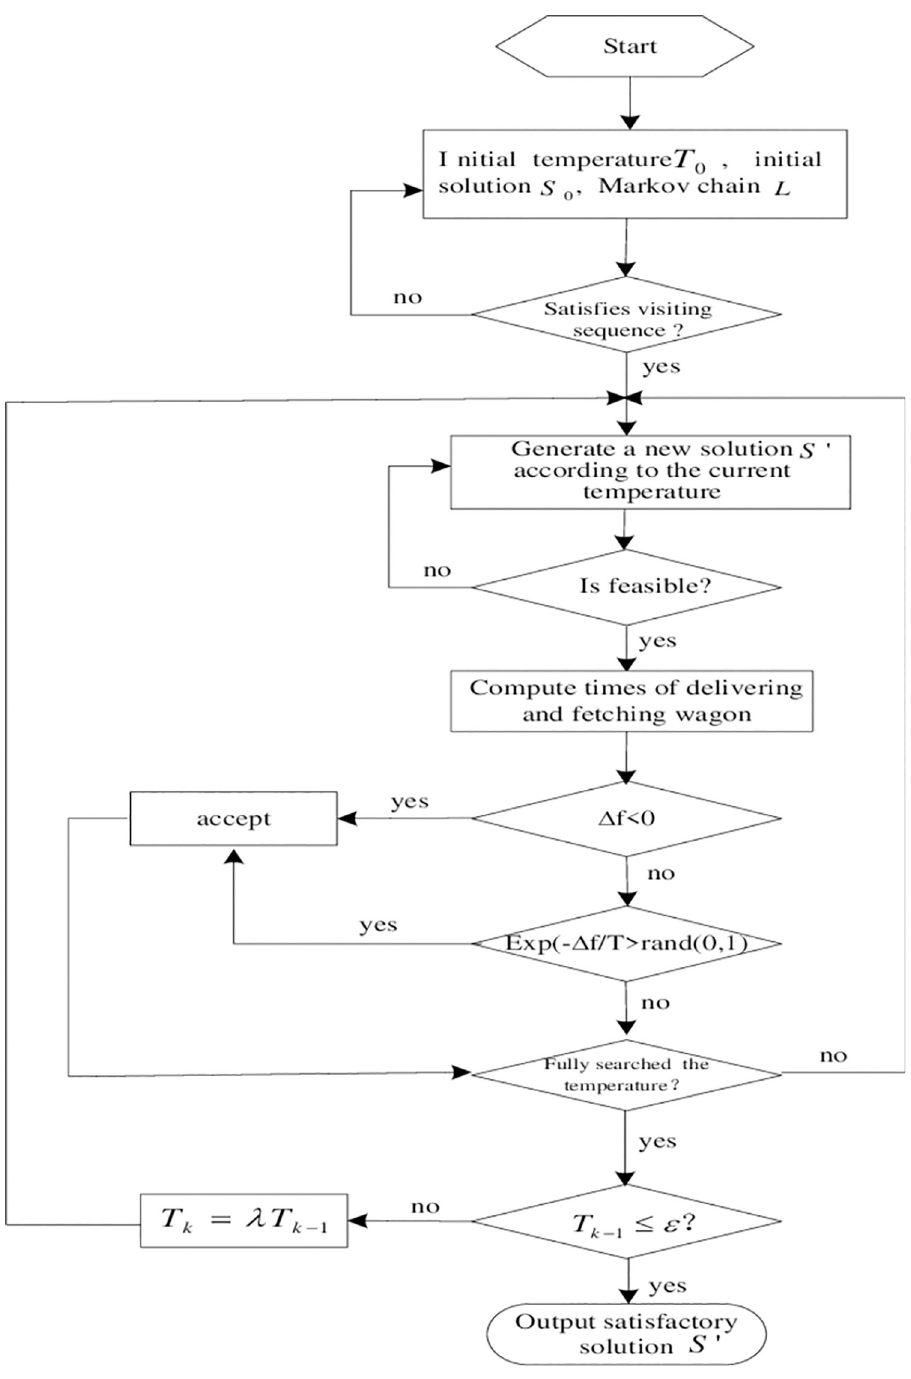
comparison. Set the parameters of simulated annealing algorithm(SA), genetic algorithm(GA) and tabu search algorithm as Table